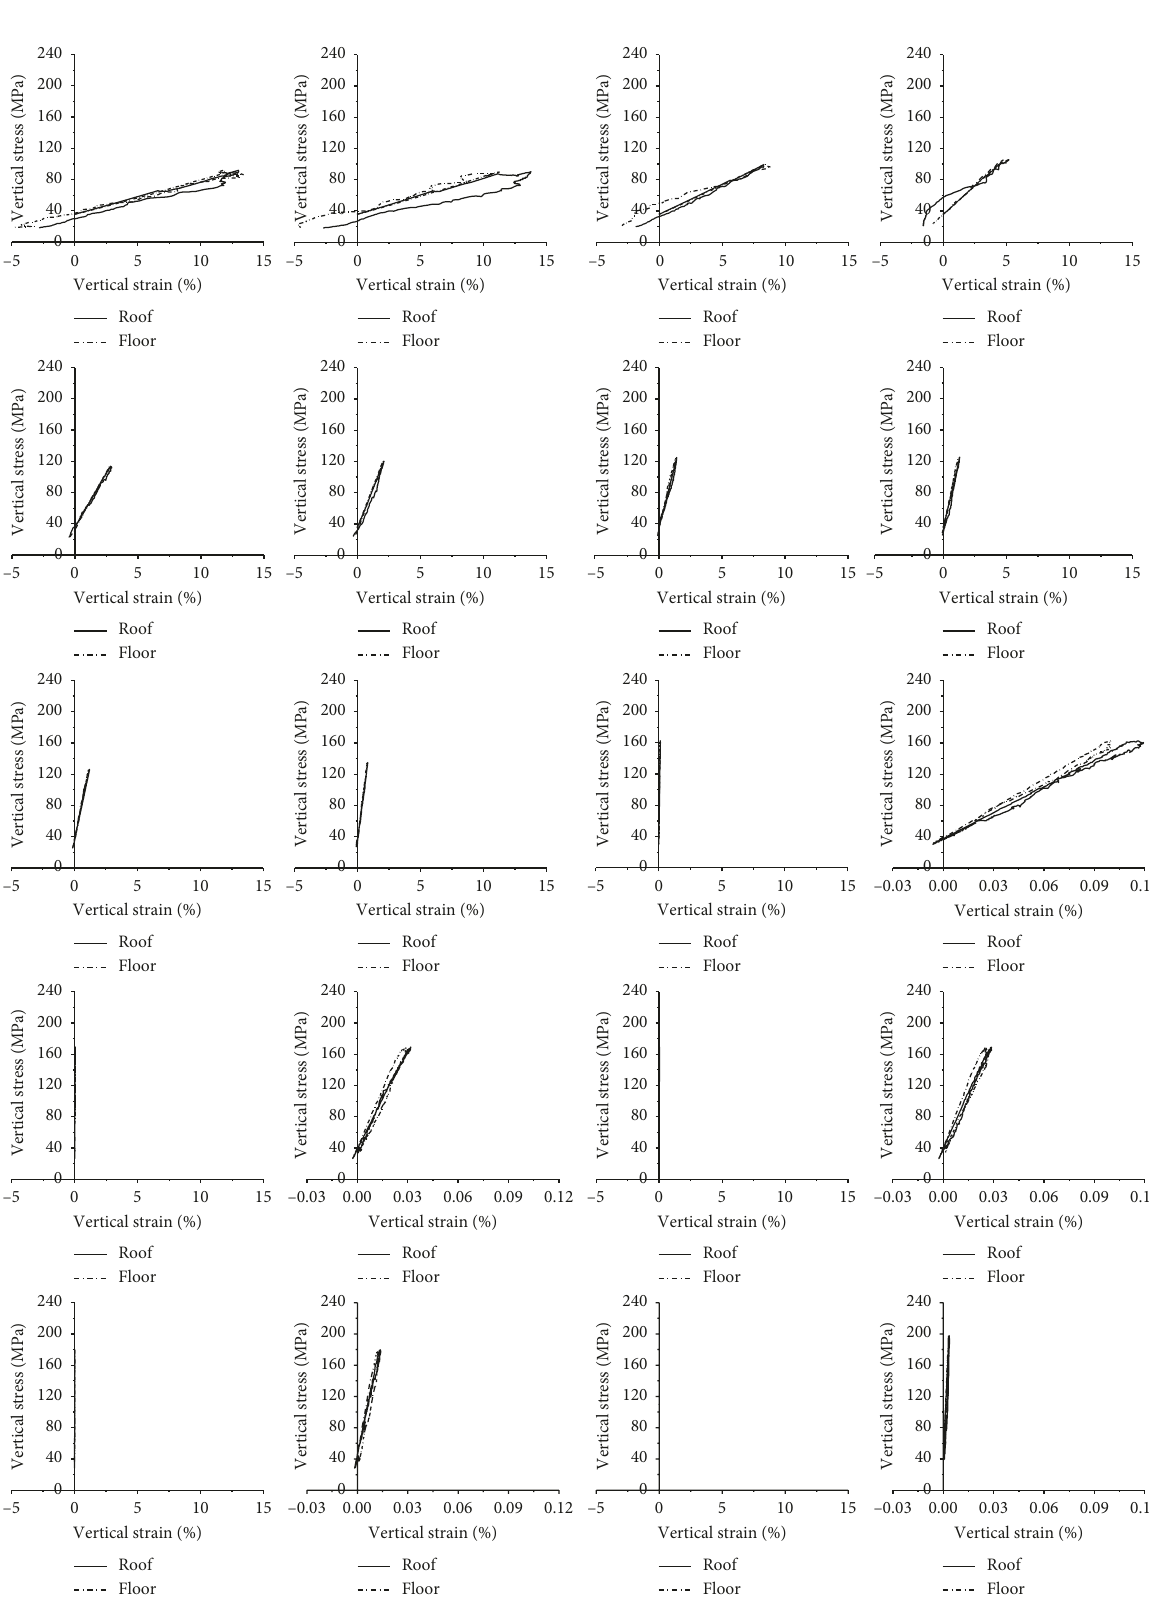
Figure 10: Vertical stress-strain curves of the roof and floor after unloading on one side of the excavation wall under various system stiffness. The two numbers under each graph are Young’s modulus ratio ( R E ) and stiffness ratio ( R K ), respectively. The magnification of the last five graphs is also plotted due to the relatively small